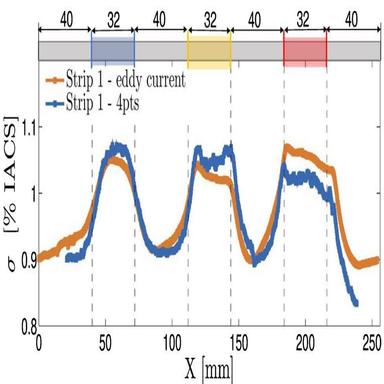
Comparison of electrical conductivity profile of FGM using eddy current testing and four-point probe testing.